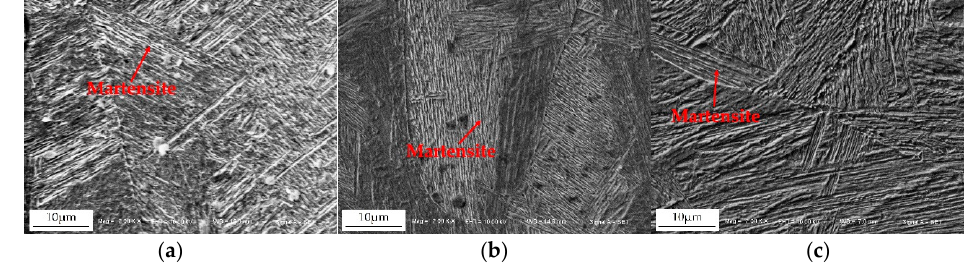
Figure 10. Effect of the typical welding current on the microstructure of the weld nugget: ( a ) 8.5 kA; ( b ) 10.5 kA; ( c ) 12